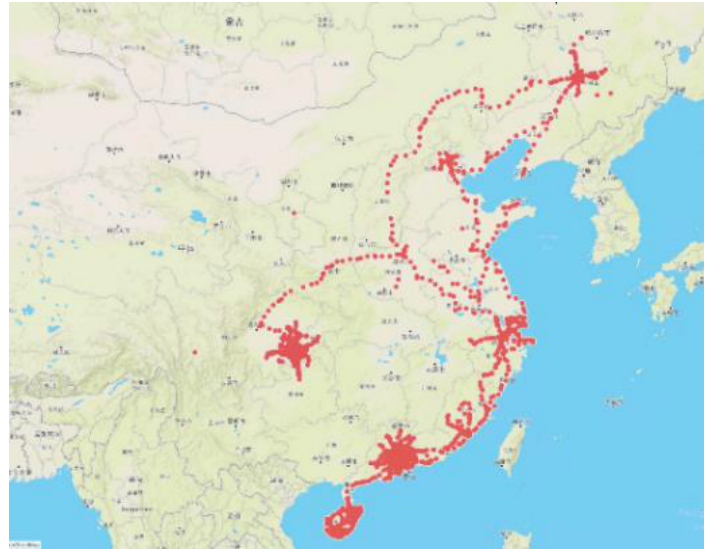
Figure 9. The distribution of the collection areas of the NDD.